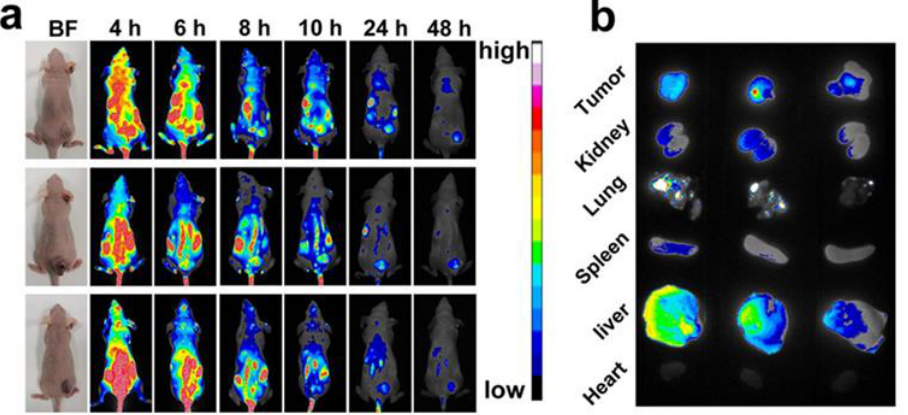
Figure 6. ( a ) In vivo fluorescence imaging of ICG-MB distribution in three CT26 colon can- cer-bearing mice. ( b ) Ex vivo imaging of tumors and other main organs at 48 h post treatment. mice. ( b ) Ex vivo imaging of tumors and other main organs at 48 h post